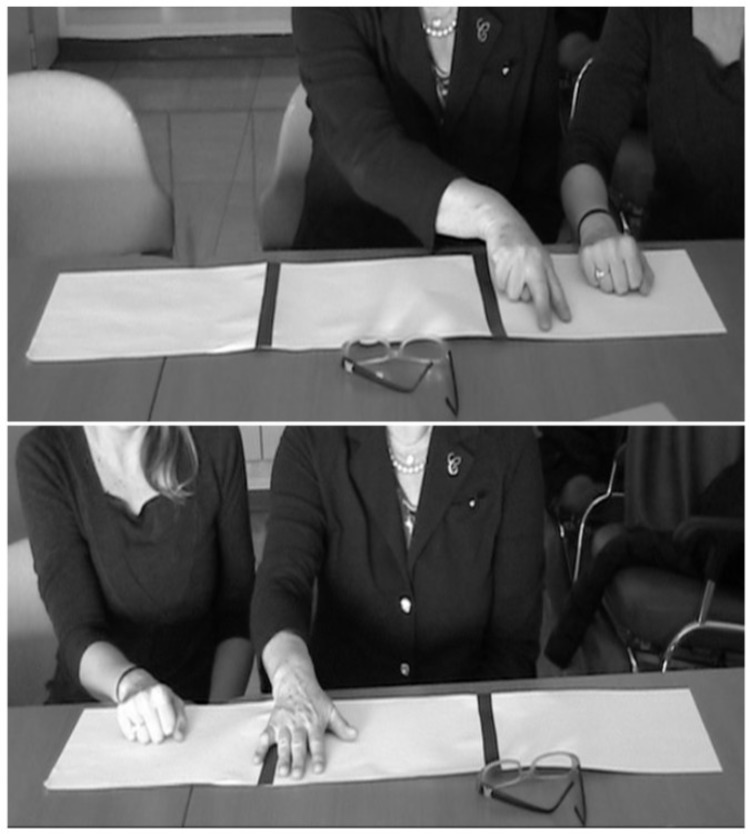
Example of Overlap (Top) and Near (Bottom) CIB observed in imitation of gestures in Patient 2.